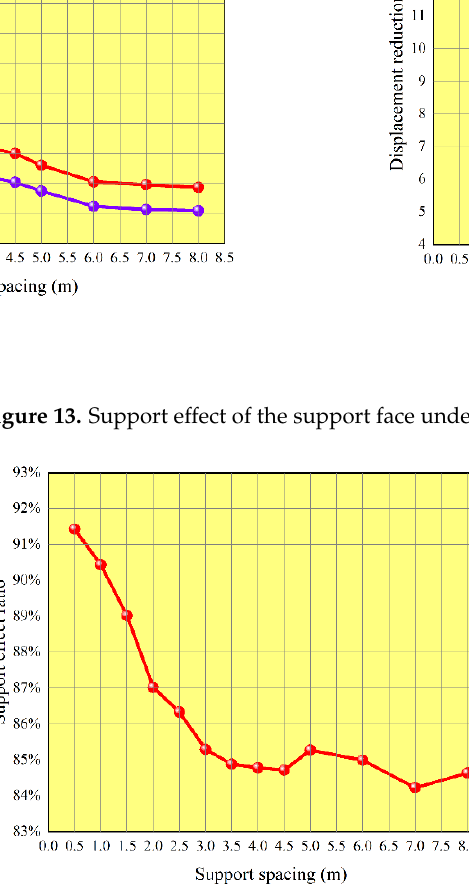
Figure 14. Support effect ratio of the non-radial support to radial support.